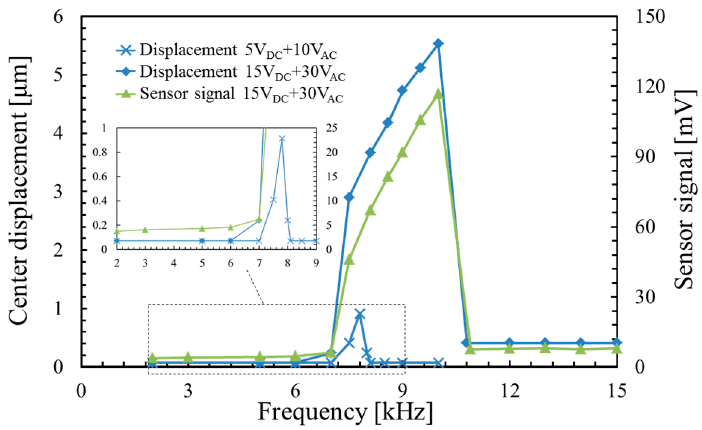
Figure 10. Frequency response of the deformation of the varifocal mirror and the piezoresistor.